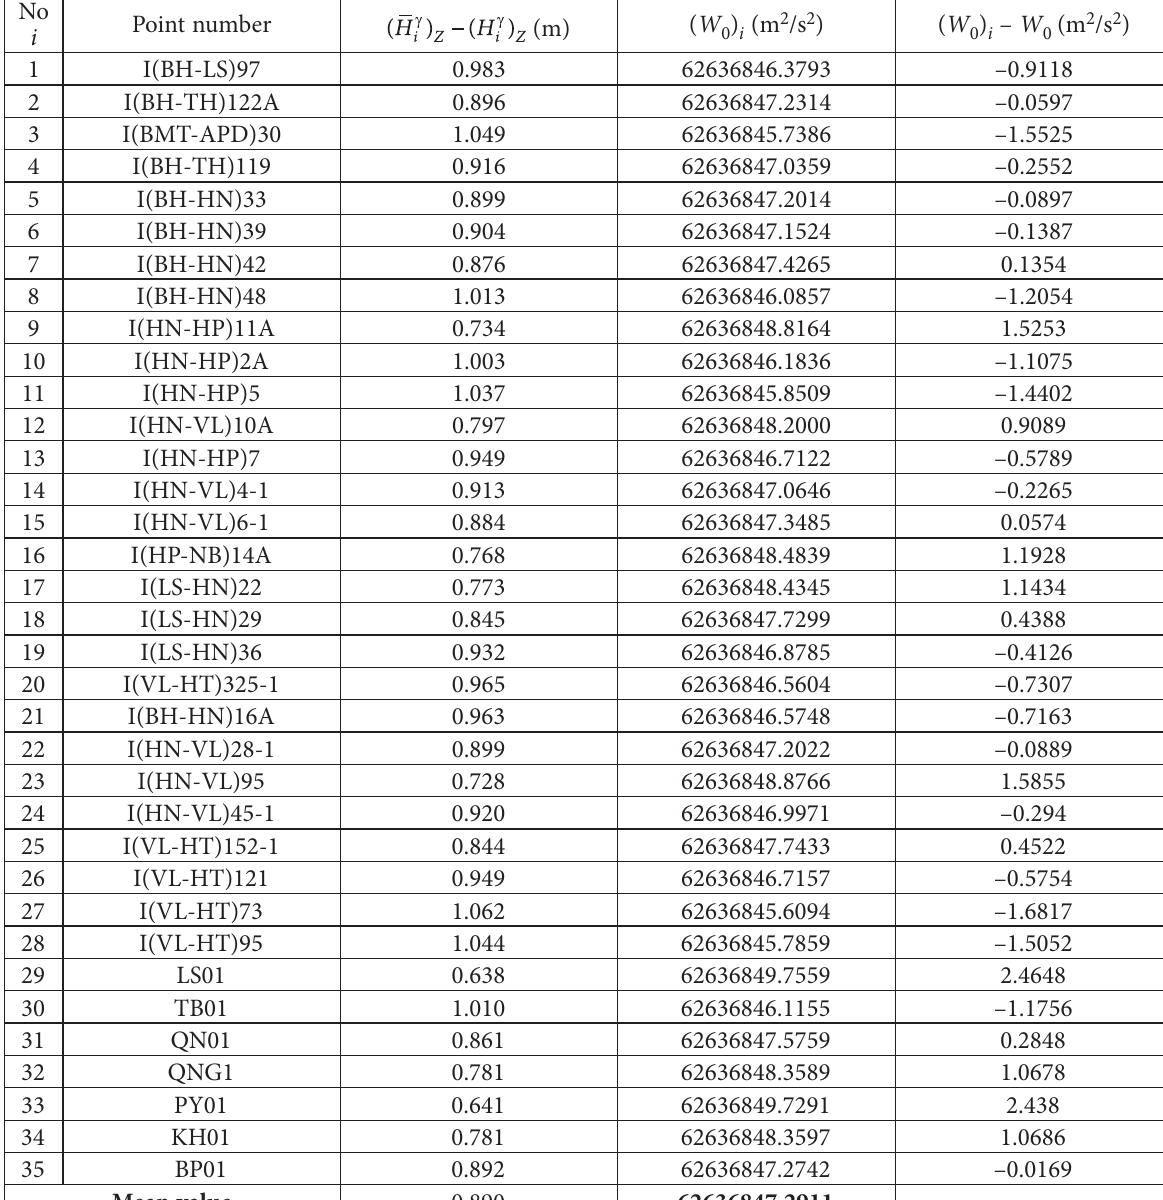
of local geoid at the tide gauge station HON 0